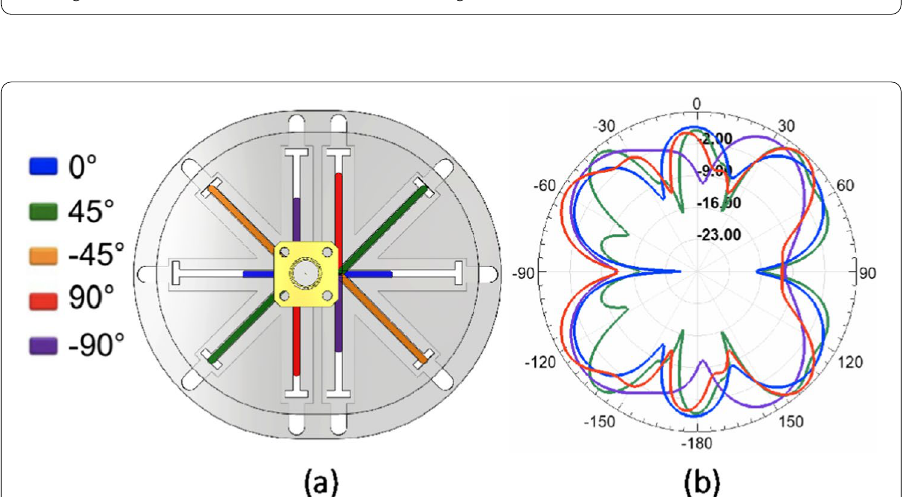
Fig. 8 Liquid metal antennas. The reconfigurable liquid metal dipole antenna ( a ) device structure ( b ) simulated radiation patterns. This structure allows the flexibility to vary independently both the length and orientation in each arm. Adapted from